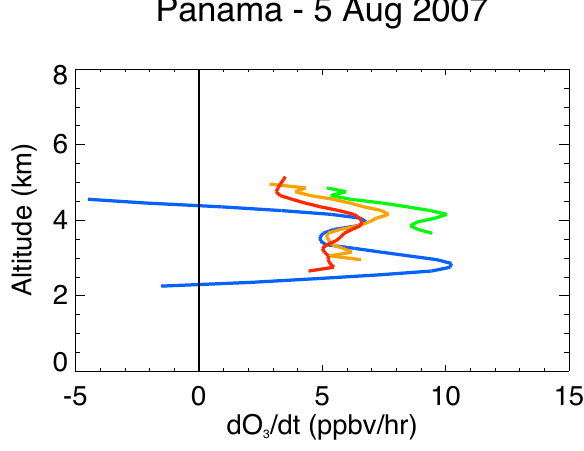
Fig. 9. Calculated dO 3 /dt vs. altitude for the ascents of the flight on the 5 August 2007 flight, with color coding to match the ascents identified in Fig. 4. See text for details.